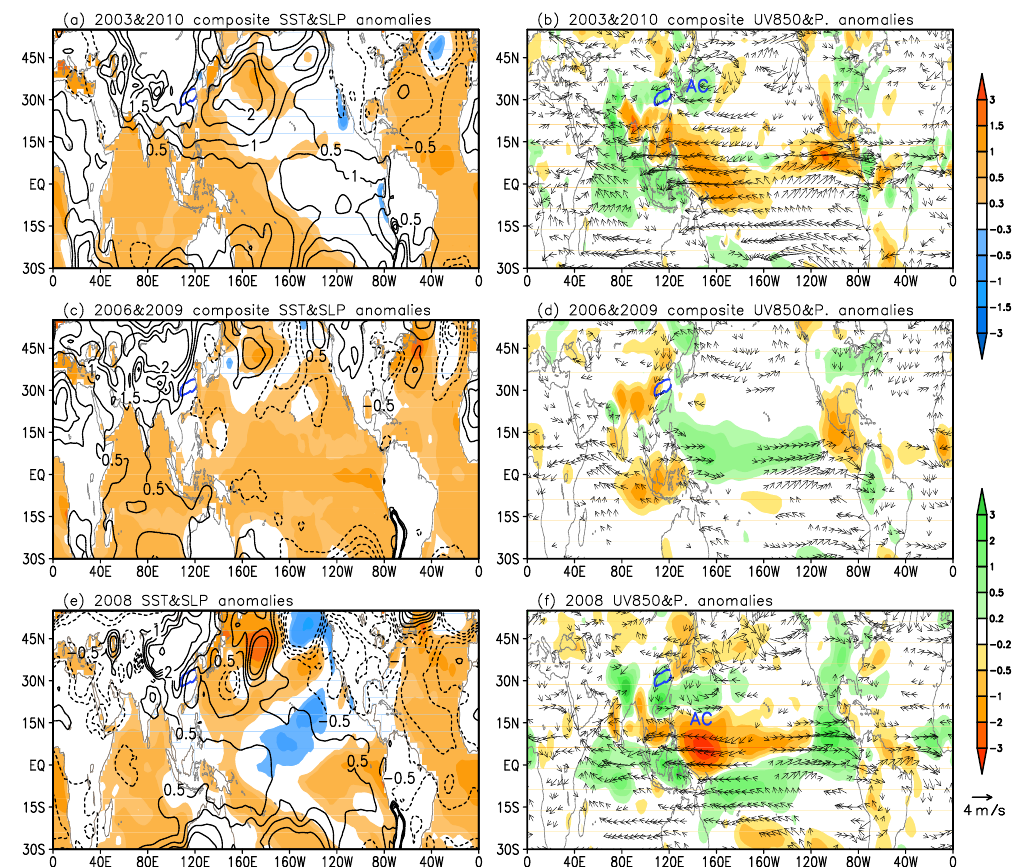
Figure 8. Composite sea surface temperature (SST) (shading, °C), SLP (contours, hPa), 850-hPa wind (vectors, m s −1 ) and precipitation (shading, mm d −1 ) anomalies during the summer(s) after ( a , b ) strong El Niños (2003 and 2010), ( c , d ) weak La Niñas (2006 and 2009), and ( e , f ) strong La Niña (2008). The blue contour denotes the region of the MLRYB; “AC” indicates the center of anticyclonic anomalies.